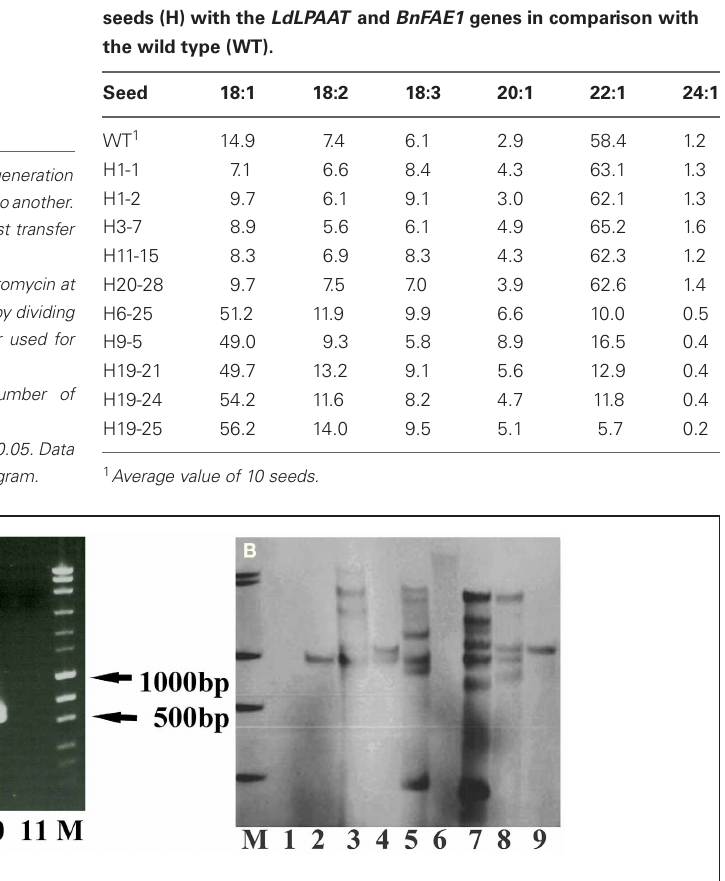
from Fermentas). (B) Southern blot analysis of genomic DNA digested with Bgl II and hybridized with the hpt probe. M, DIG labeled molecular markers. Lane 1, wild type. Lane 2–9, transgenic